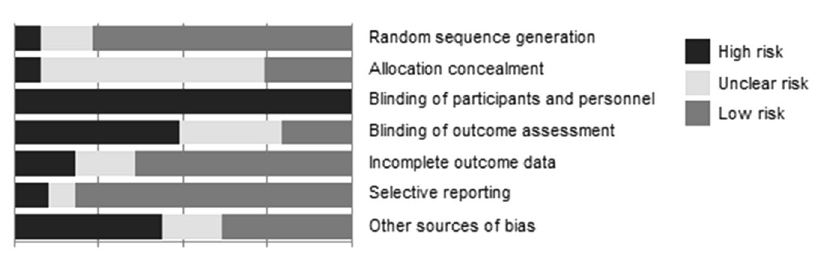
Fig. 2 Quality assessment of included studies. Percentages represent the percentage of included articles having a high risk ( black bar ), unclear risk ( light grey bar ) or low risk ( medium-grey bar ) of bias for each category in the Cochrane Collaboration ’ s risk of bias assessment